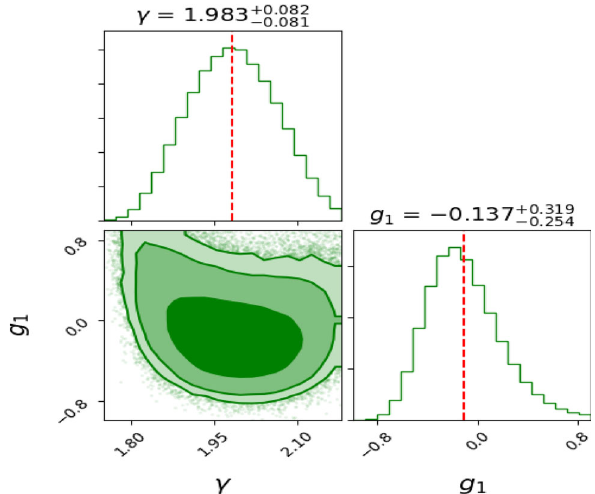
Fig. 6 For High mass range SGL sample: The 1D marginalized likeli- hood distributions along with 2D marginalized constraints showing the 68%, 95%, and 99% credible regions for the parameters γ (from the power law model describing the SGL systems) and g 1 (from the gas depletion factor g ( z ) ), obtained using the Corner python module [70]